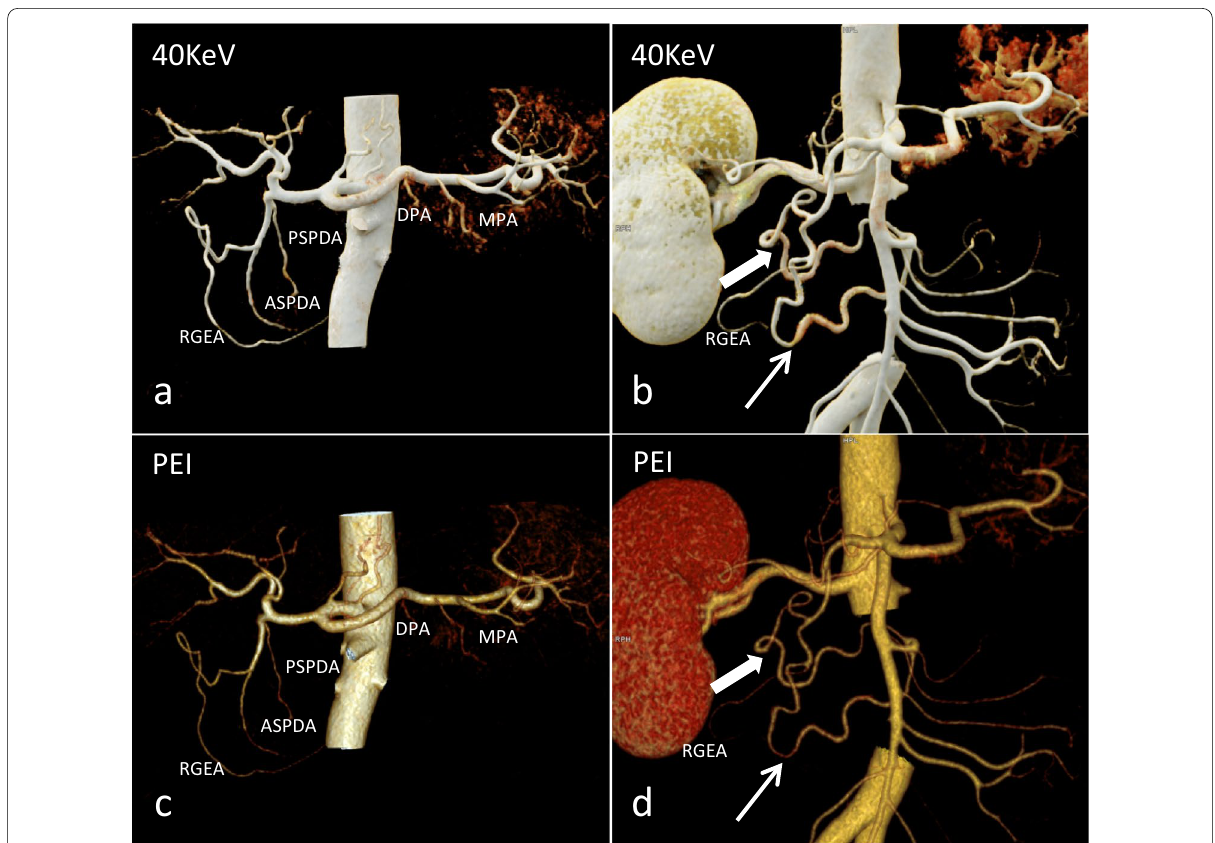
Fig. 4 The upper (a, b) and lower (c, d) rows show the 40‑keV MEI ( contrast‑enhanced CT angiography shows the anterior superior pancreaticoduodenal artery (ASPDA), posterior superior pancreaticoduodenal artery (PSPDA), dorsal pancreatic artery (DPA) and magnificent pancreatic artery (MPA). b VRT shows standard anterior (thin arrow) and posterior (thick arrow) pancreaticoduodenal arcade. The visualization is better on the 40‑keV MEI (